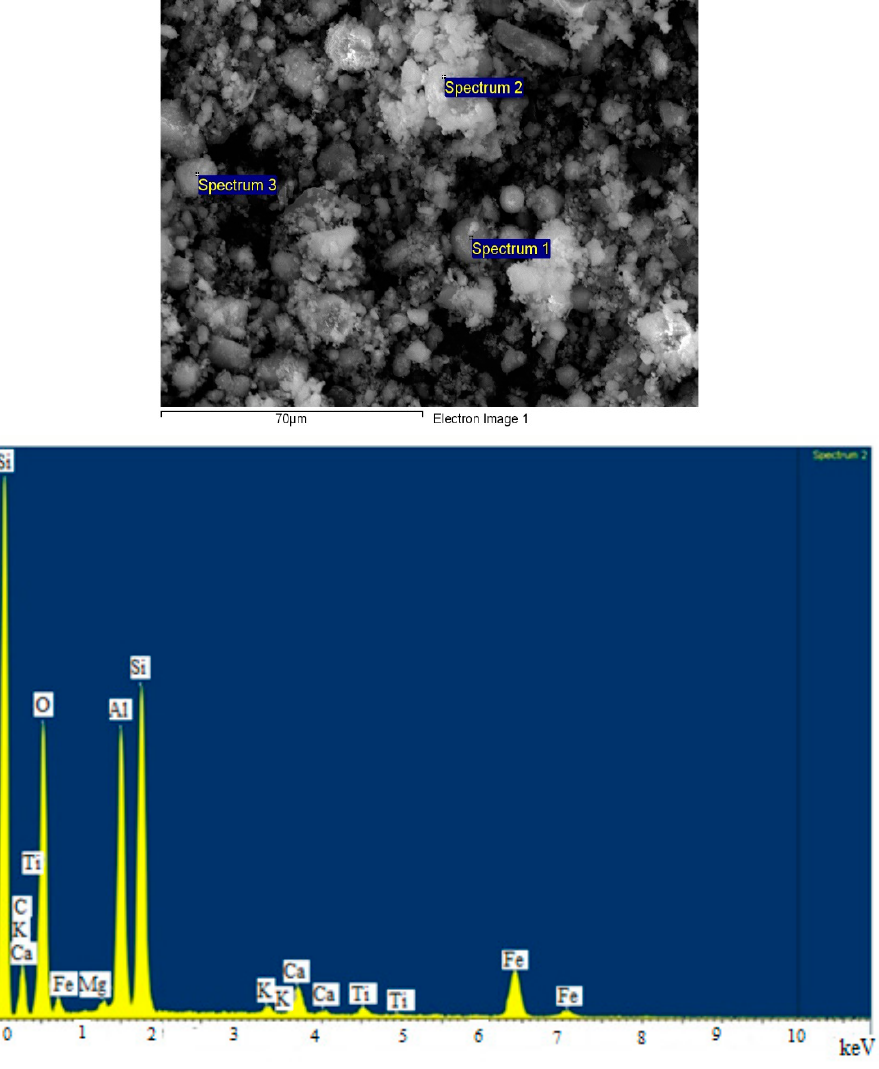
Figure 2. EDAX spectrum of FA/Fe 3 O 4.